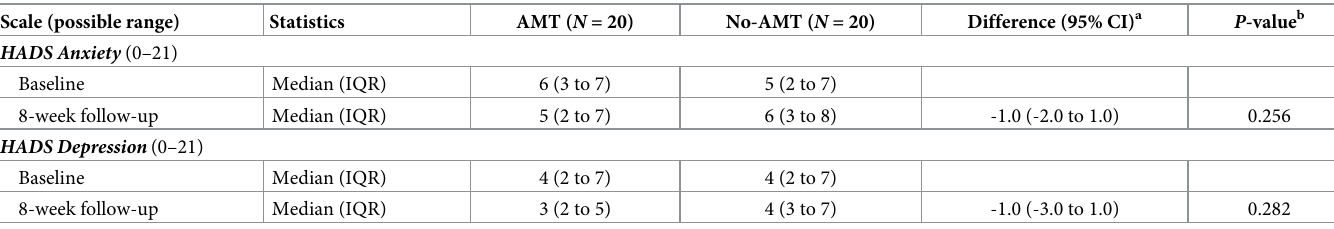
Table 4. Analyses of Hospital Anxiety Depression Scale (HADS)